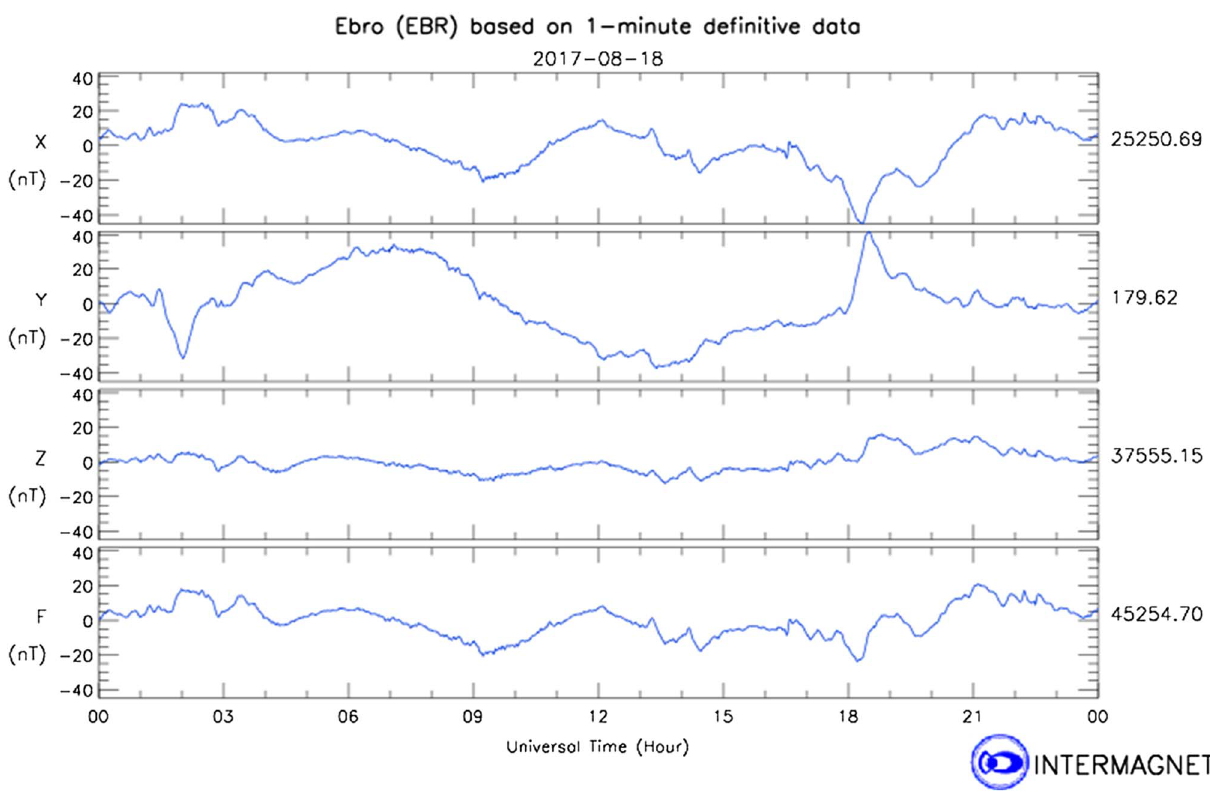
Fig. 12. Ebro magnetogram corresponding to August 18, 2017. Magnetospheric disturbances prevented observers from detecting Sfe